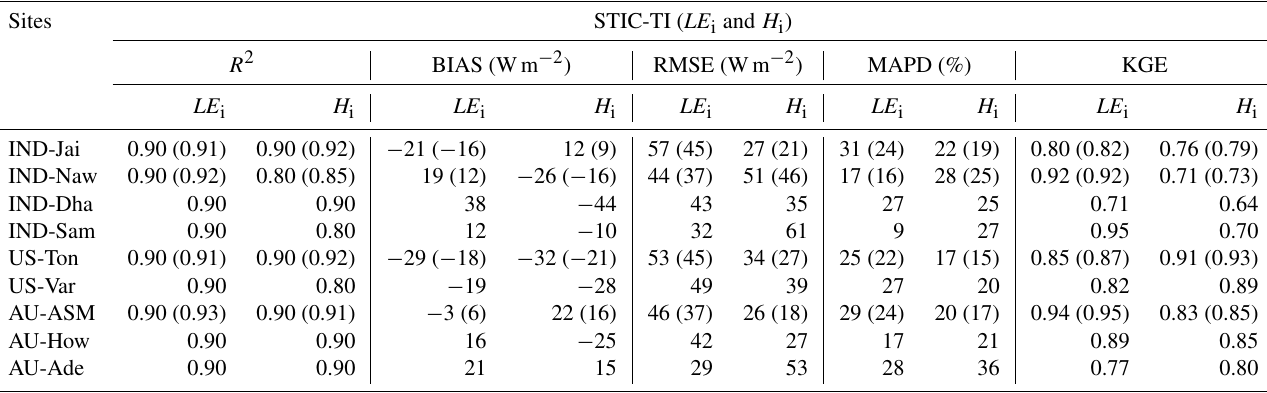
Table 5. Error statistics of STIC-TI LE i and H i estimates with respect to EC measurements in different ecosystems of India, the USA, and Australia using the MYD11A2 LST product for all nine sites and using the MYD21A2 LST product for three semi-arid and arid sites. The statistics obtained by using MYD21A2 LST are shown in the